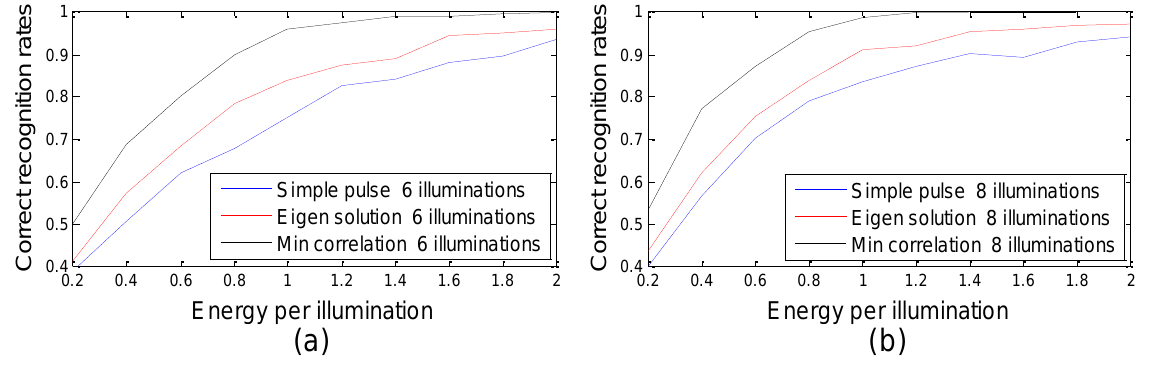
Figure 6. Waveform spectra compared to target spectral variance. Eigen-waveform solution is shown in (a) and the minimum correlation algorithm is shown in (b)